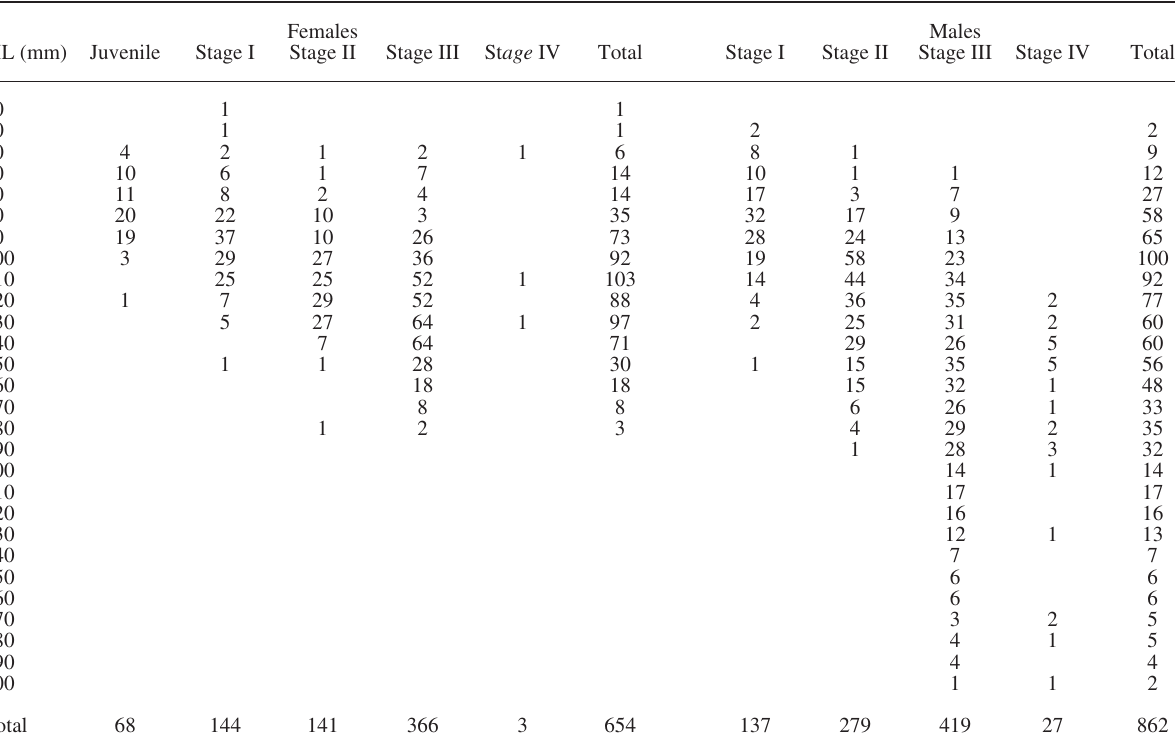
Table 1. – Numbers of Loligo plei measured for each class, sex and maturity stage from samples taken by commercial shrimp trawlers in 1999-2000 and 2002-2003. ML = mantle length.